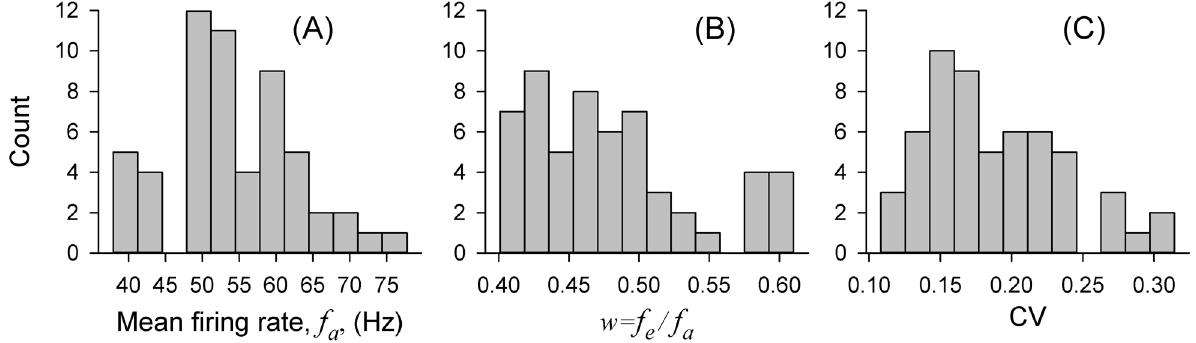
Figure 6. Histograms of firing statistics for a sample of n ~ 56 paddlefish ER afferents, including distributions of the mean firing rate, f a , A, the ratio of EO to AO frequencies, w ~ f e = f a , B, and the coefficient of variation, CV, C. These graphs are for different number of afferents than used in Fig. 6 of Ref. [18].